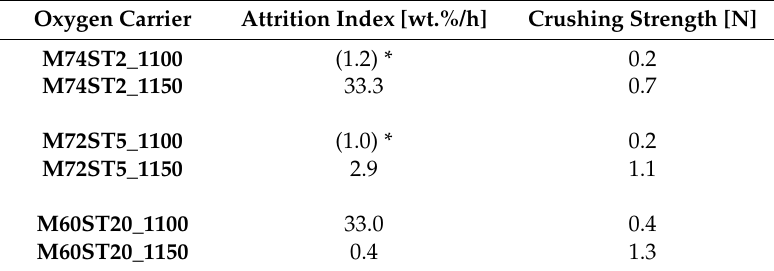
Table 4. Attrition index (used particles) and crushing strength.